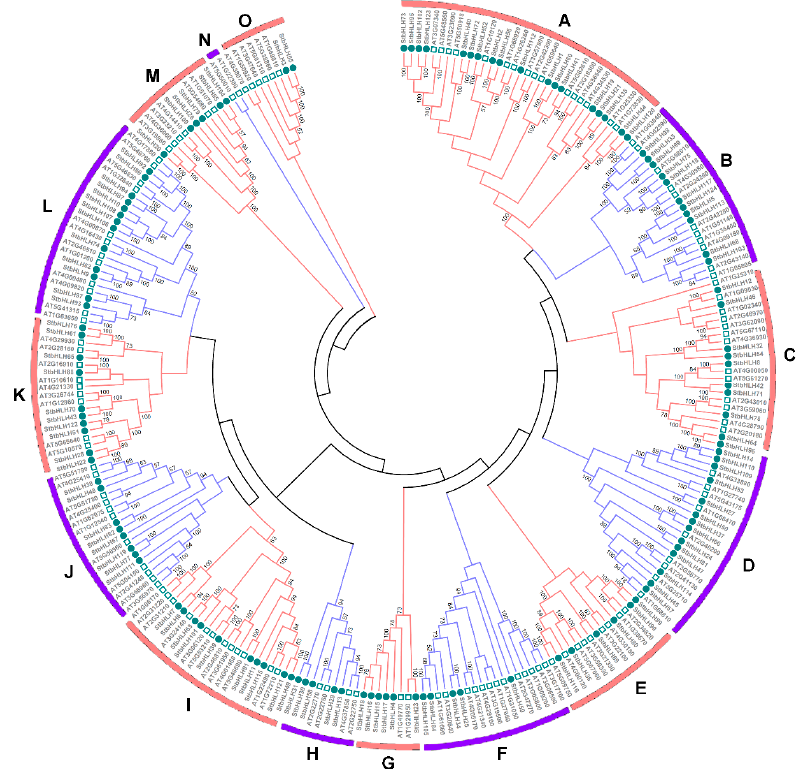
Figure 2. Phylogenetic tree of Arabidopsis and potato bHLH proteins. The phylogenetic tree was constructed using the Neighbor-joining method with 1000 bootstrap replications. The 15 subfamilies are marked with different colors. The circles represent potato bHLH proteins, and the rectangles represents Arabidopsis bHLH proteins.